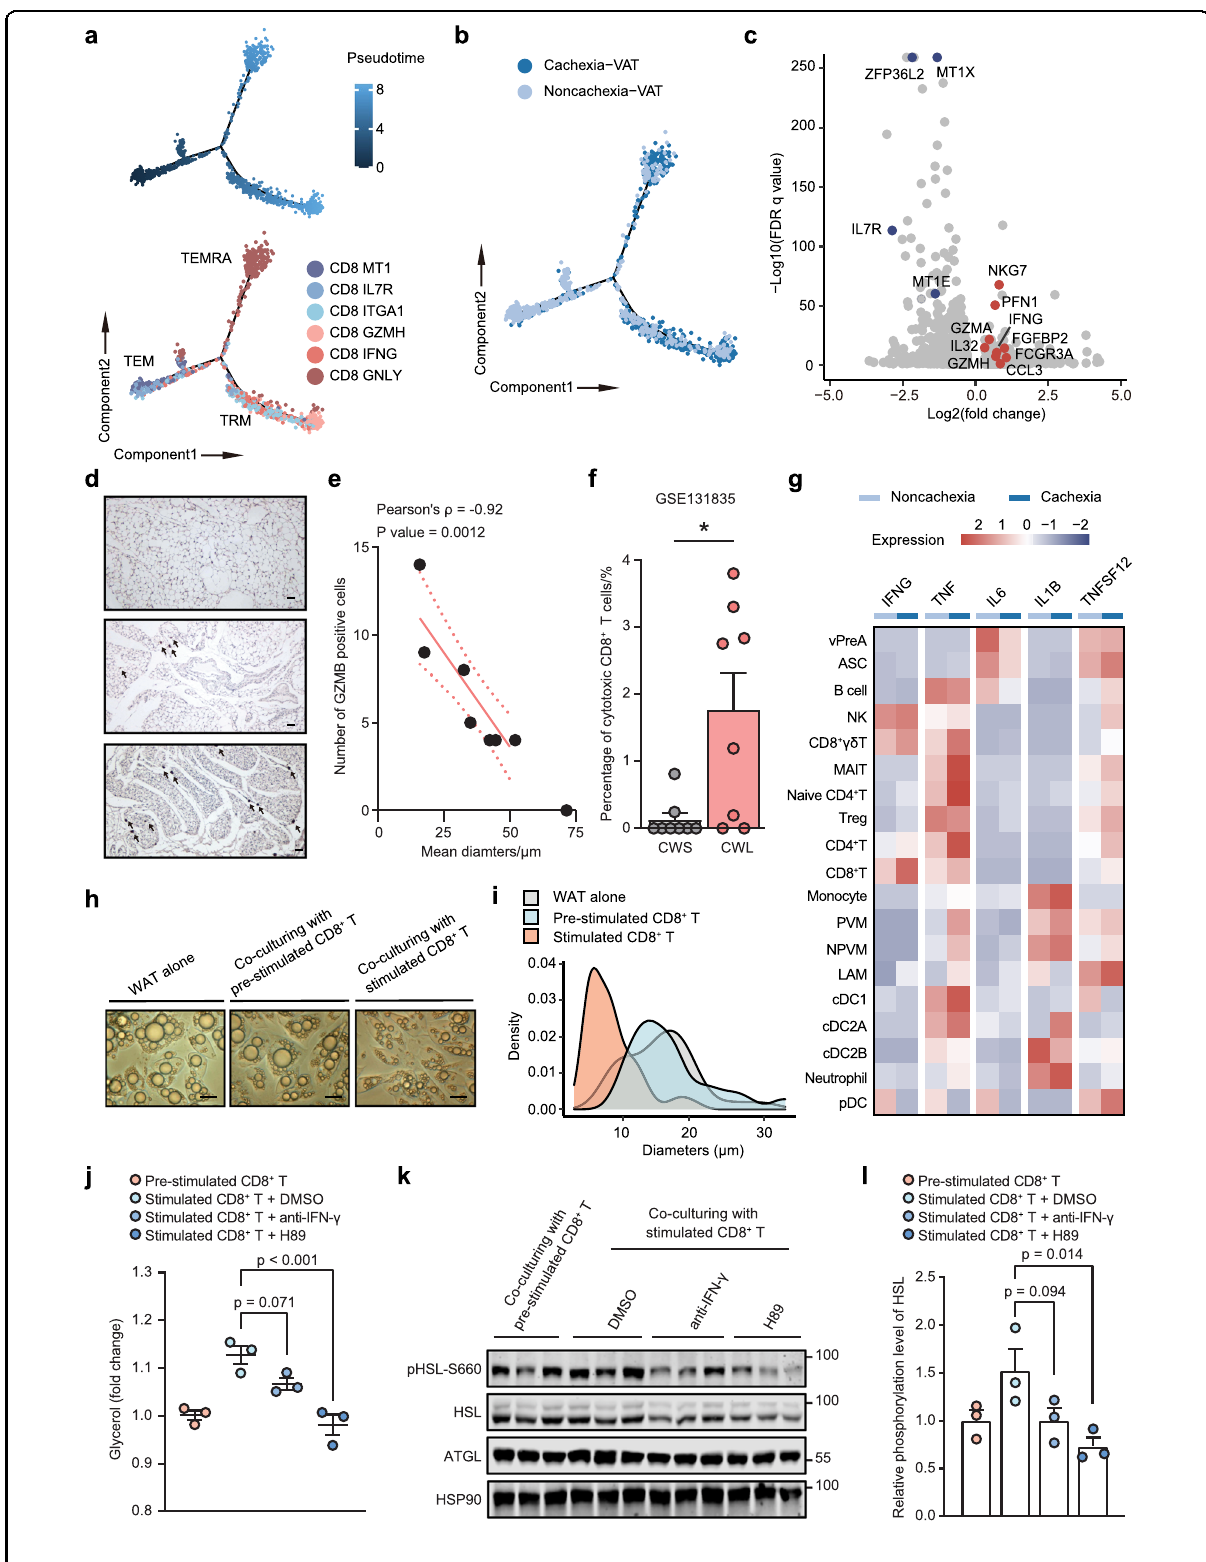
Fig. 6 (See legend on next